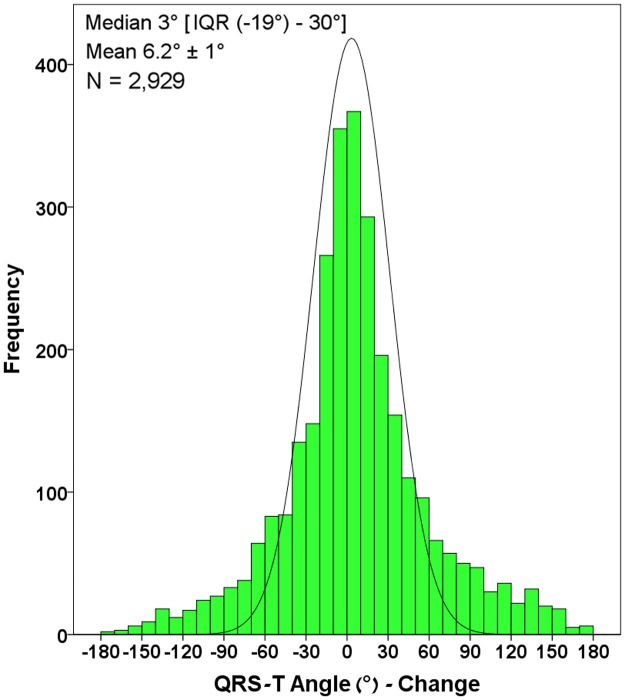
Changes in the QRS-T angle.Histogram of the QRS-T angle difference in degrees between baseline and follow-up ECG. The continuous line denotes the normal distribution curve.